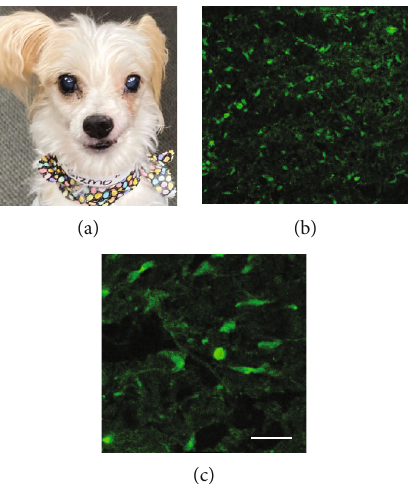
Figure 8: The photograph in (a) depicts the appearance of the mass presented in Figure 7 after debulking, cauterization and 4 rounds of treatment with TOL. The photomicrograph in (b), compared to the photomicrograph in Figure 7(b) and Figure 7(c), depicts the signi fi cant reduction in the number of cells that highly express VGSCs (green) following treatment with TOL. The calibration bar in (c) is 25 μ m.